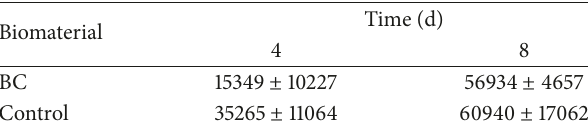
Table 2: Cell density on BC with time. Plates for cell culture of polystyrene were used as